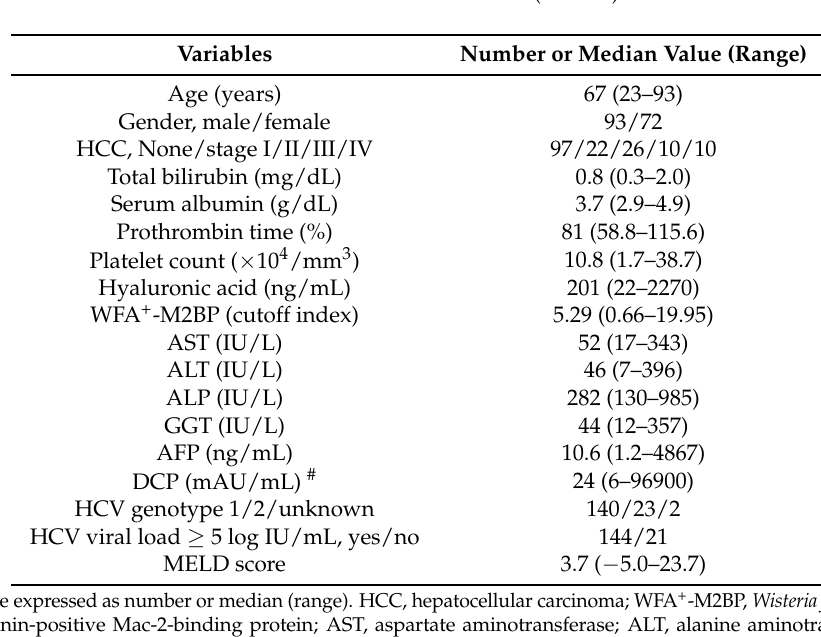
Table 1. Baseline characteristics ( n =